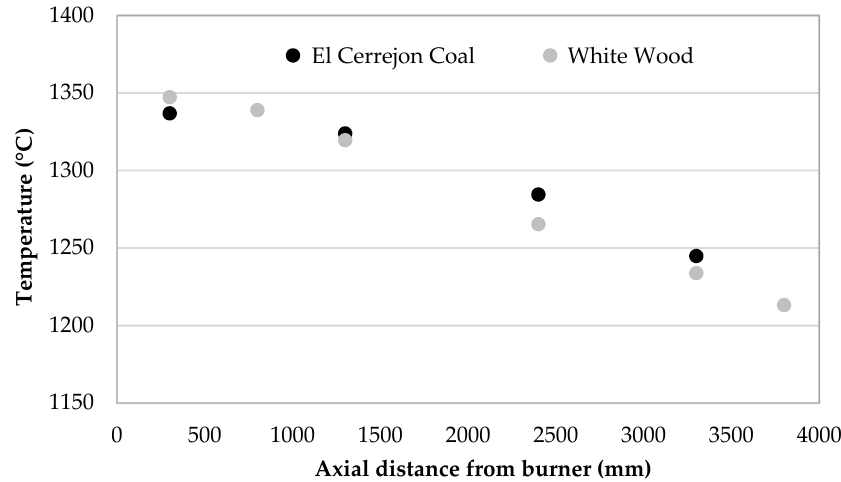
Figure 3. Furnace temperatures for coal- and biomass-fired cases, recorded with fixed thermocouples at 250 mm radial distance from furnace axis and various axial distances from the burner.